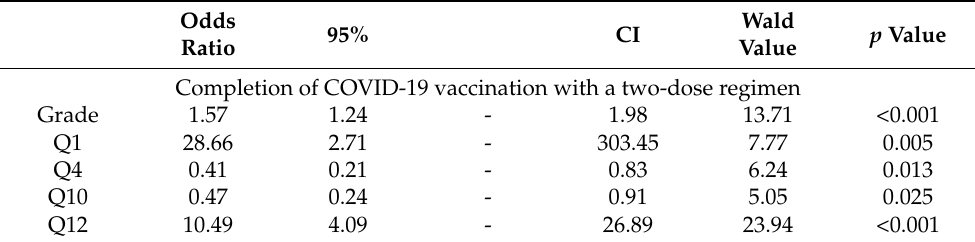
Table 3. Factors associated with completion of COVID-19 vaccination with a two-dose regimen and willingness to receive the COVID-19 vaccine in the